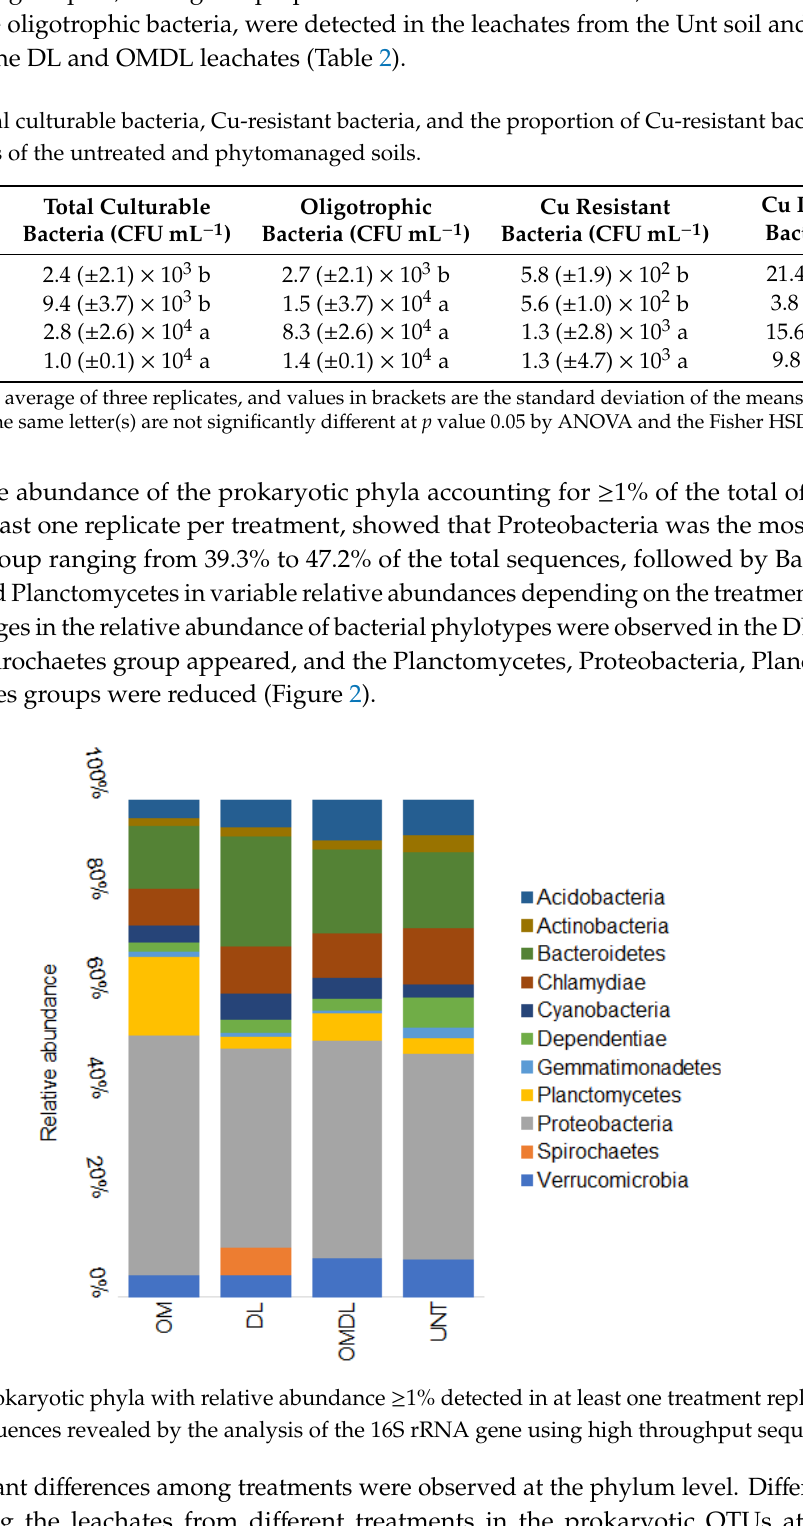
Table 2. Total culturable bacteria, Cu-resistant bacteria, and the proportion of Cu-resistant bacteria in the leachates of the untreated and phytomanaged soils.